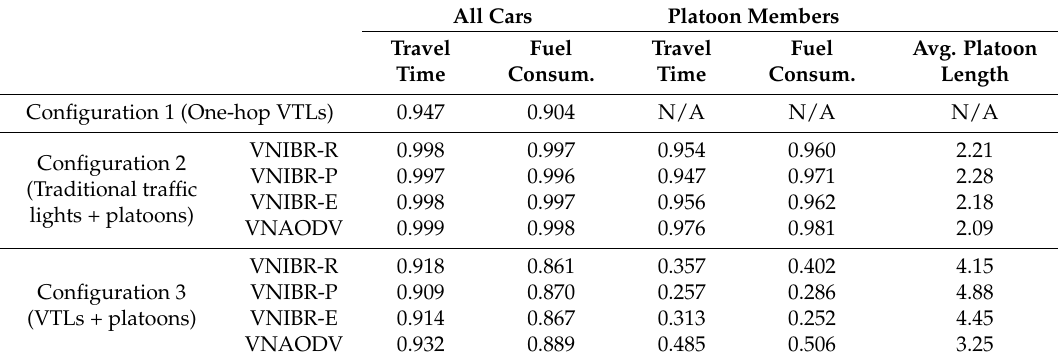
Table 2. Results for medium traffic density (time and fuel normalized regarding best average values from configuration